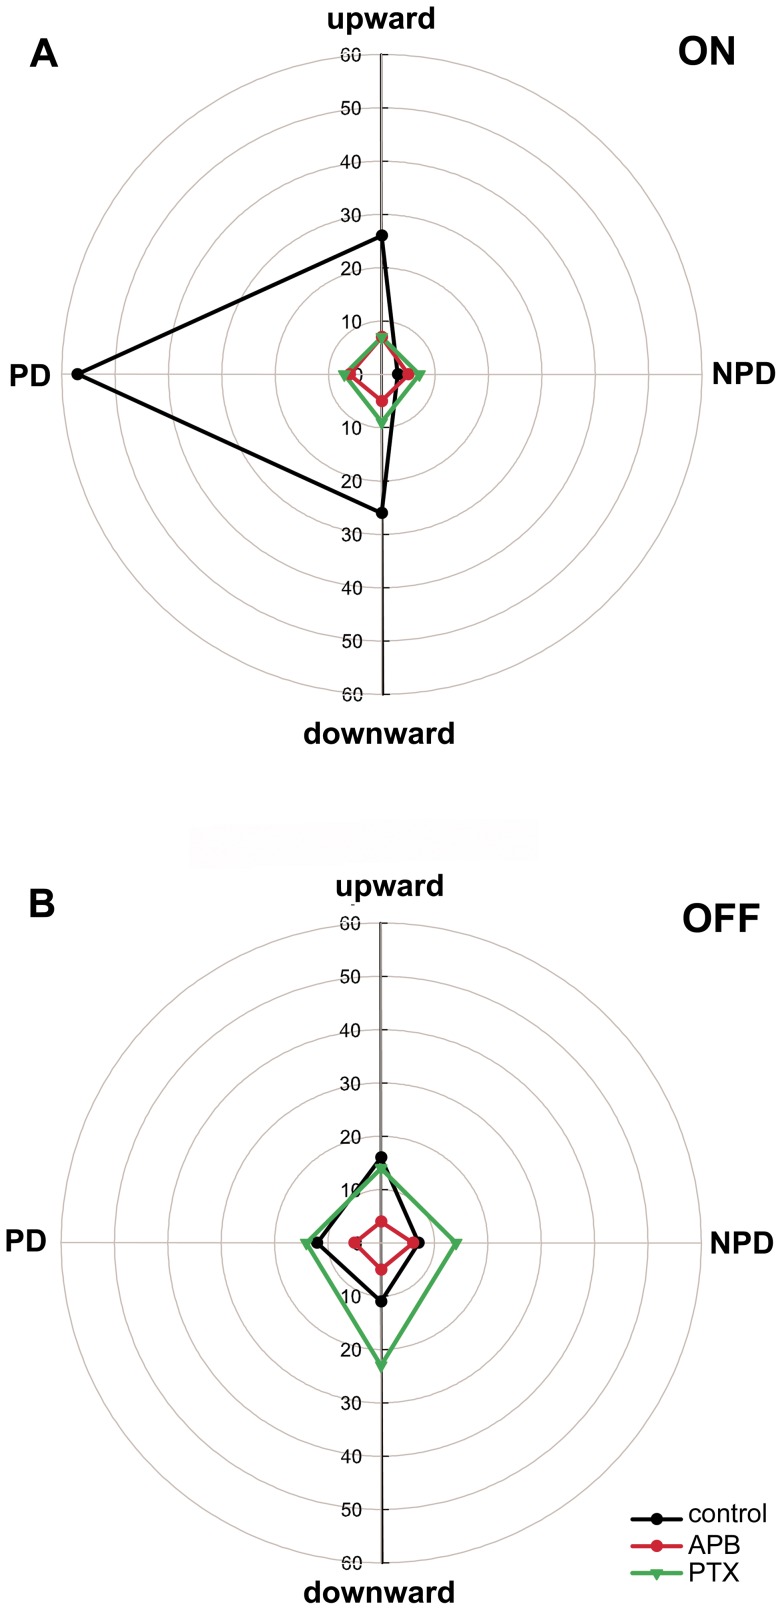
Effects of 2-amino-4-phosphonobutyrat (APB) and picrotoxin (PTX) on the directional tuning of the light edge and dark edge responses in an example NOT-DTN unit.Polar plot of the responses during stimulation with ON (A) and OFF (B) edges moving in the four cardinal directions prior to drug application (black curves), after intravitreous injection of APB (red curves), and after additional intravitreous injection of PTX (green curves). Distance from the center of the polar plots indicates neuronal activity in spikes per second given by the numbers on the circles. PD: preferred horizontal direction, NPD: non-preferred horizontal direction. Note that after APB followed by a PTX injection an increased but direction unselective response to the moving dark edge (OFF) is uncovered.